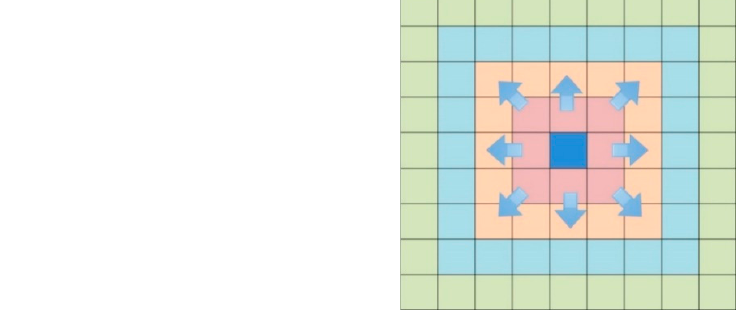
Figure 7. The wildfire algorithm.